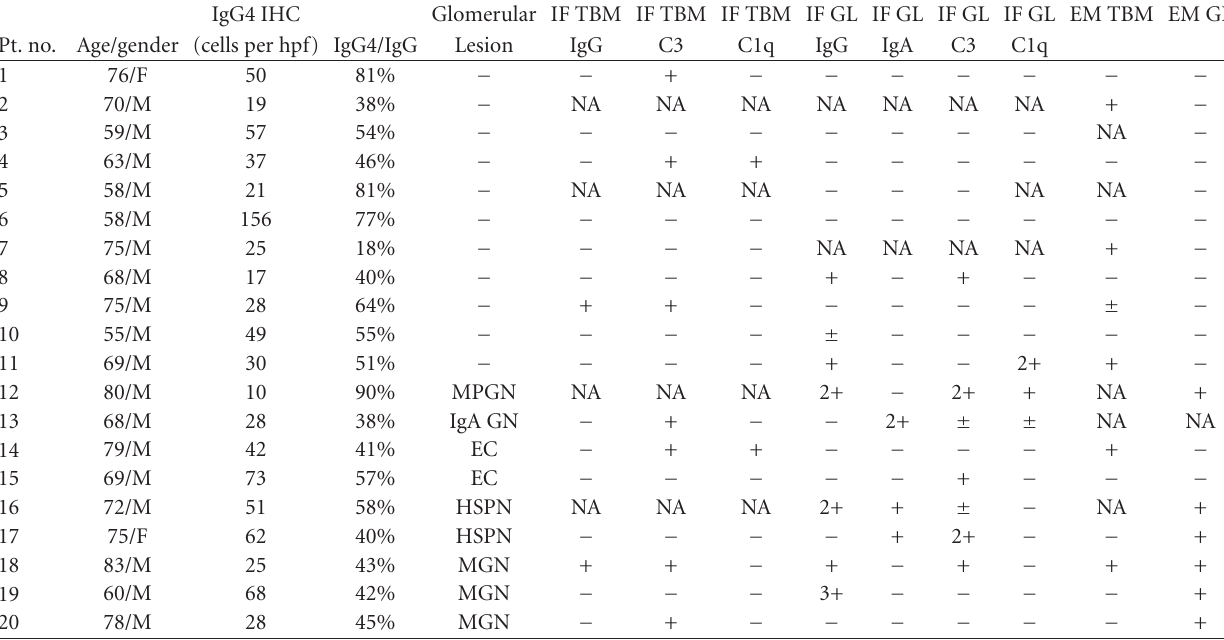
Table 2: Histologic features of IgG4-related tubulointerstitial